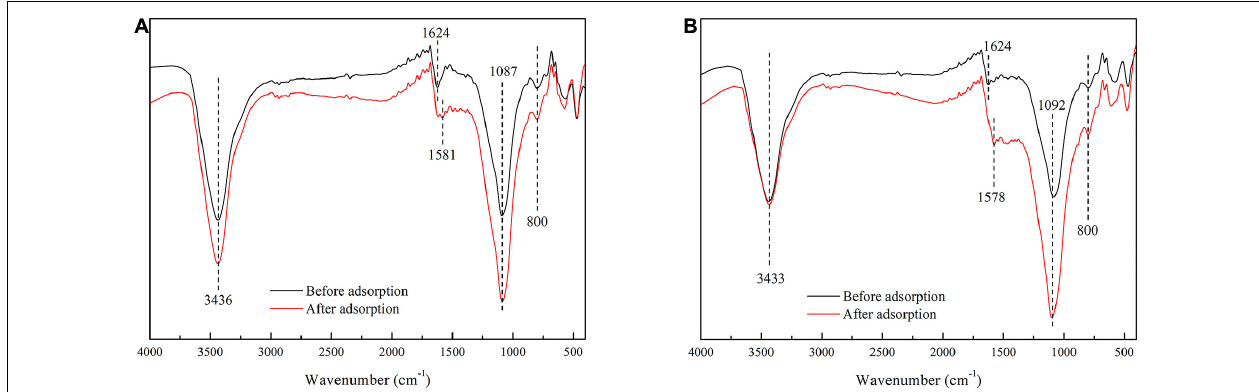
FIGURE 8 | The FTIR spectra of PBC (A) , and TPBC (B) before and after